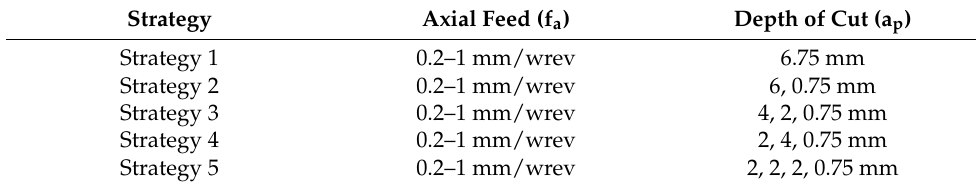
Table 2. Case study